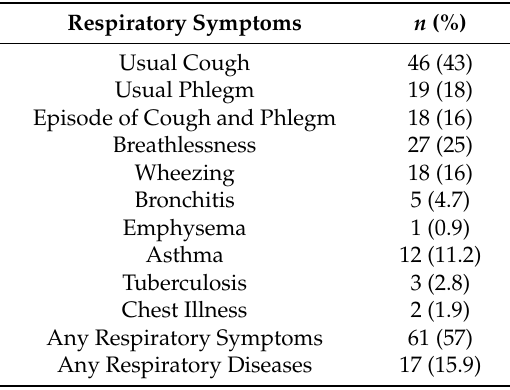
Table 5. Prevalence of respiratory health outcomes ( N =